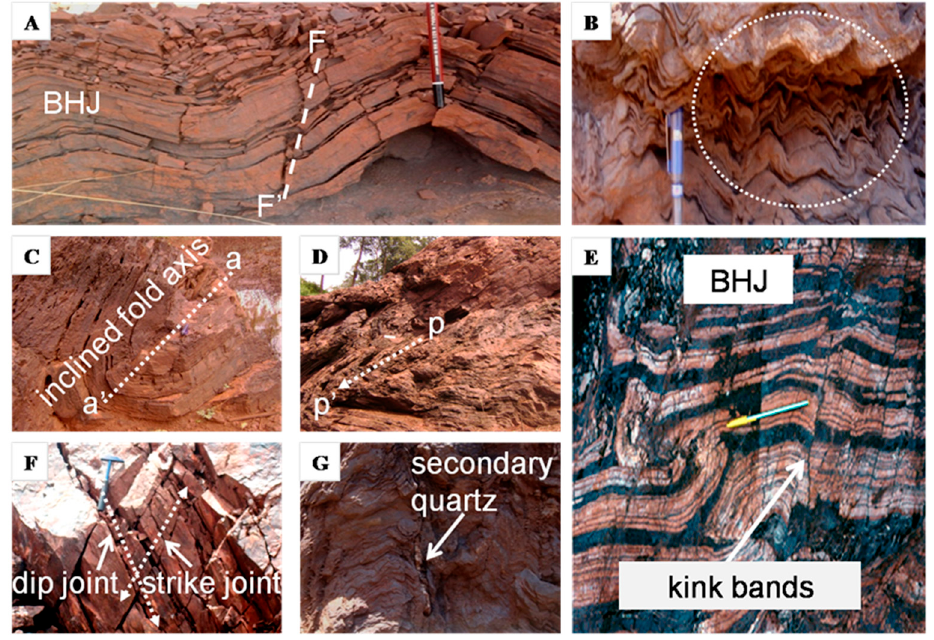
Figure 7. ( A ) Antiformal and synformal features in BHJ. Minor dislocation of bedding can be seen along FF’; ( B ) secondary folds of M-W pattern; ( C ) inclined or plunging folds in BHJ with its fold axis dipping at low angle towards NE direction; ( D ) areclined fold geometry; ( E ) kink bands in BHJ associated with younger generation folds playing significant role in ore enrichment processes through leaching; ( F ) aset of strike and dip joints developed in BHJ due to deformation; and ( G ) fractures of different orientations and dimensions in the iron formations that contain secondary minerals such as quartz, which aided the supergene process.